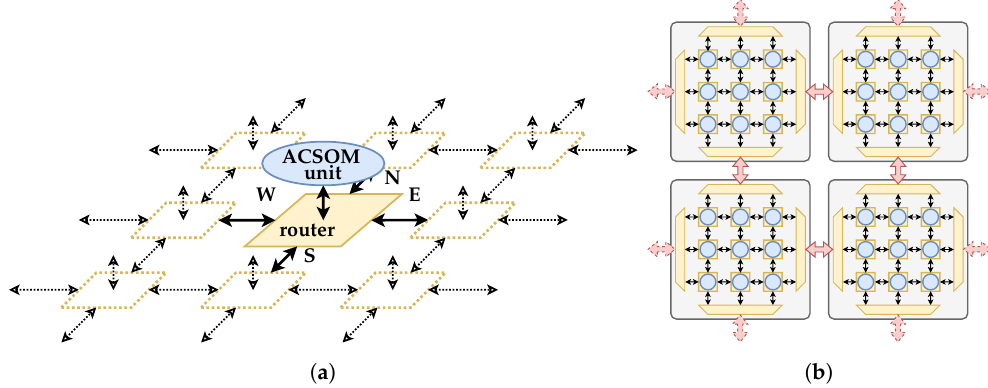
Figure 7. Example of a two-dimensional integration of ACSOM architecture in a SCALP array. ( a ) SCALP Network-On-Chip topology. ( b ) Multi-FPGA architecture. Black arrows represent AXI stream links, red arrows denote inter-FPGA high-speed serial links.